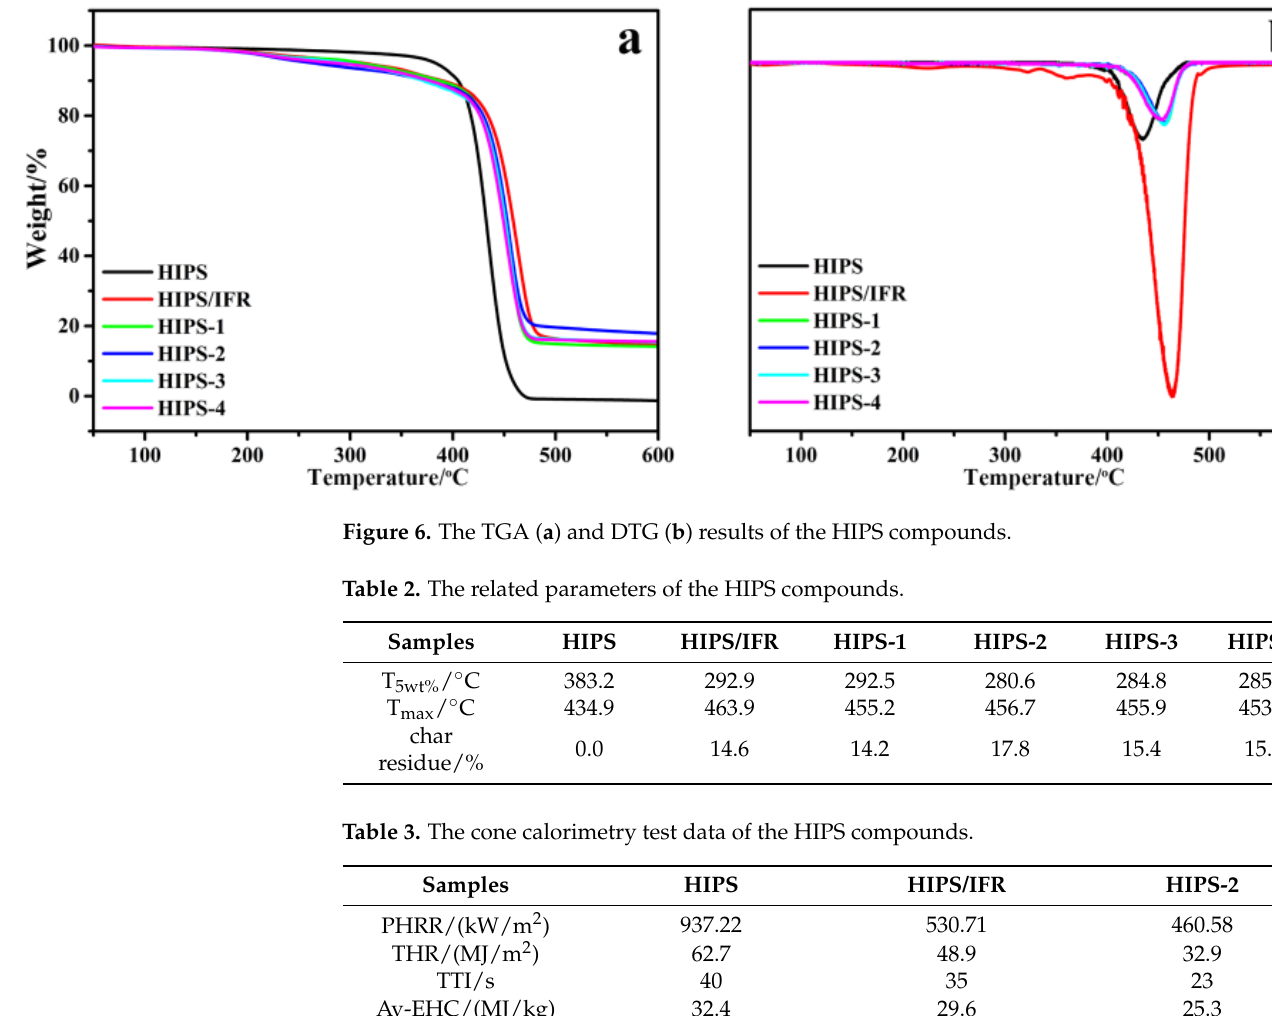
Table 3. The cone calorimetry test data of the HIPS compounds.